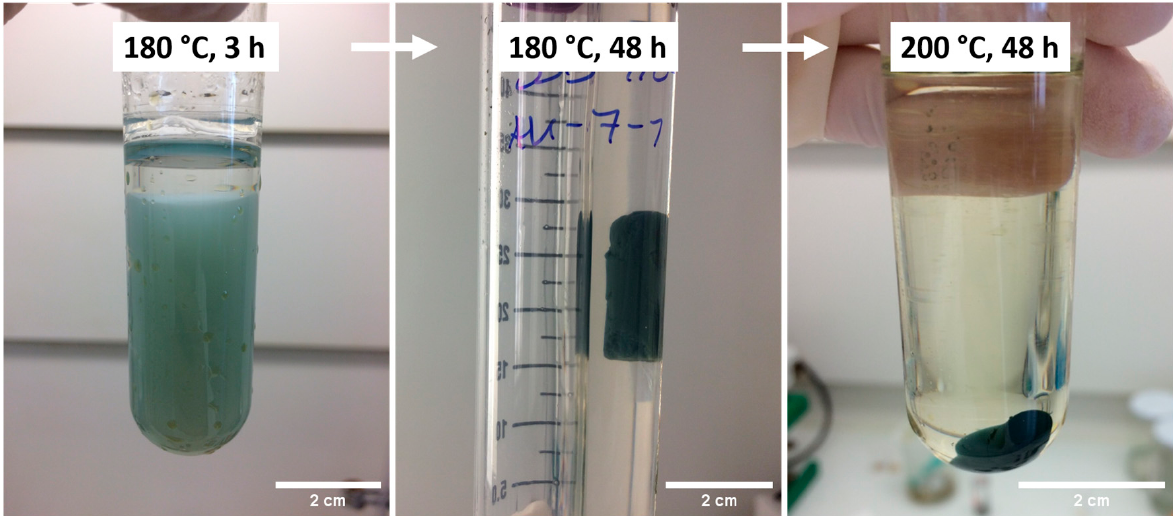
Figure 1. Photographs of the obtained synthesis products for di ff erent synthesis durations and temperatures in the nonaqueous one-pot sol–gel process.